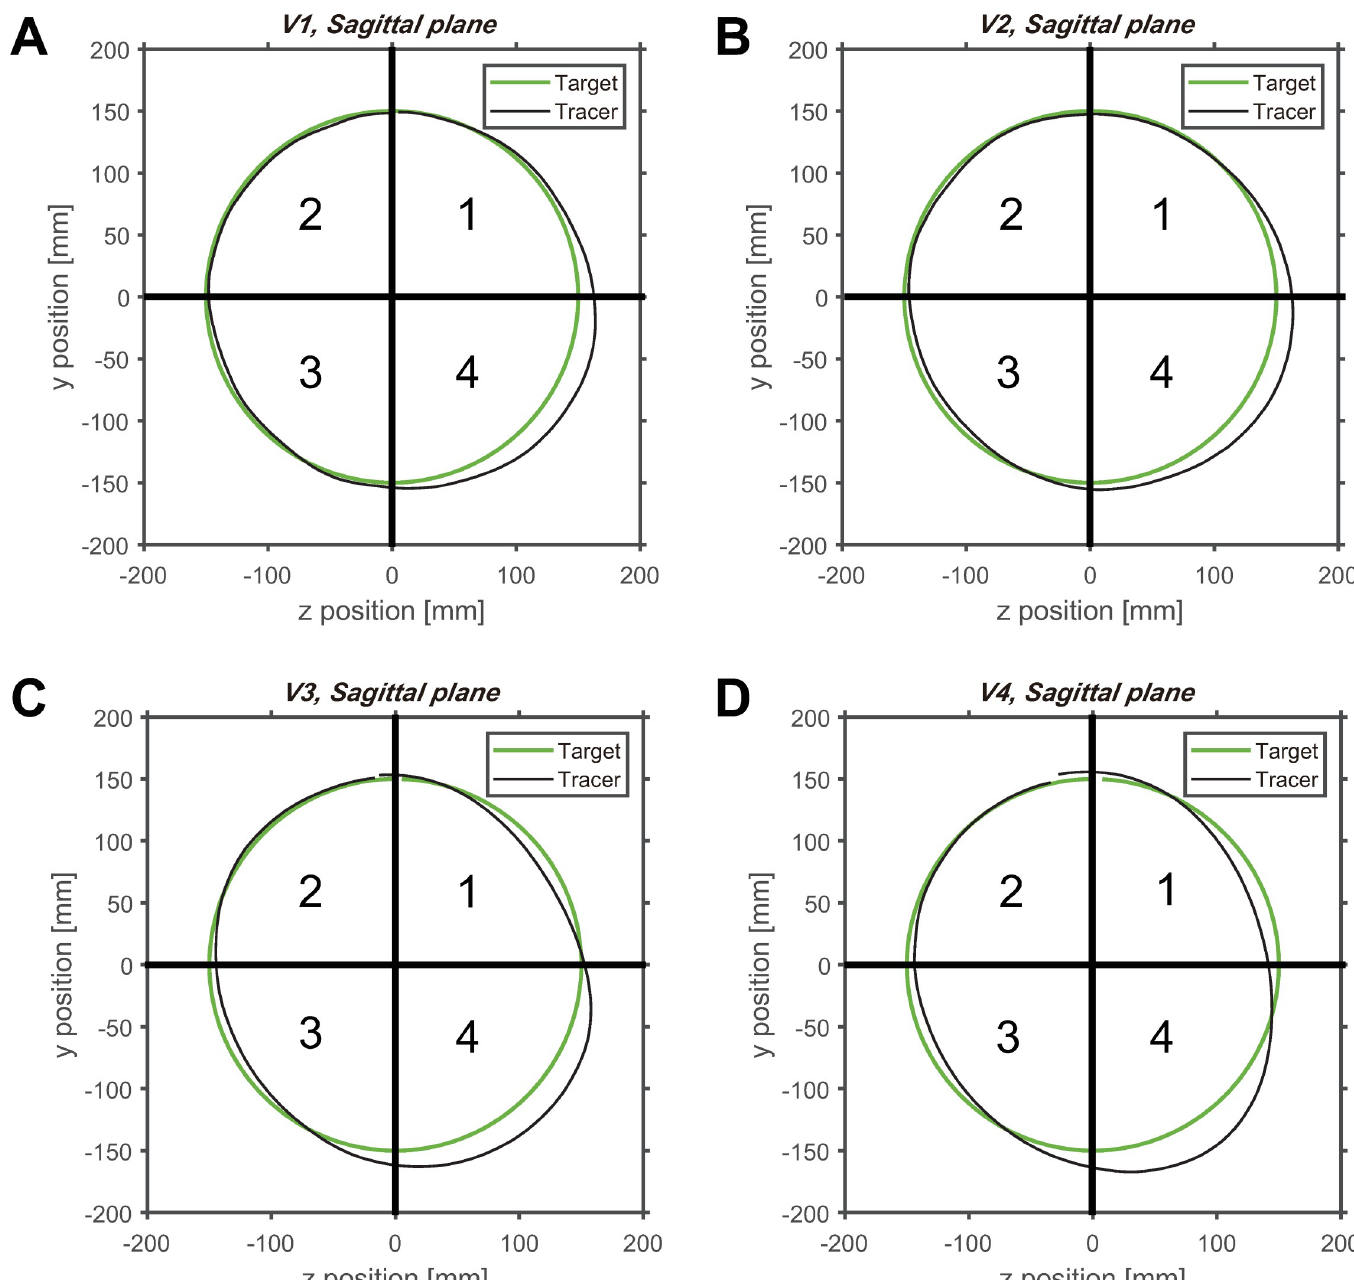
Fig 4. Average circular tracking movement in the sagittal plane. (A) The movement trajectory of the target and controller at (A) V1 (0.125 Hz), (B) V2 (0.25 Hz), (C) V3 (0.5 Hz), and (D) V4 (0.75 Hz). The order of the moving target is the Q1 , Q4 , Q3 , and Q2 .